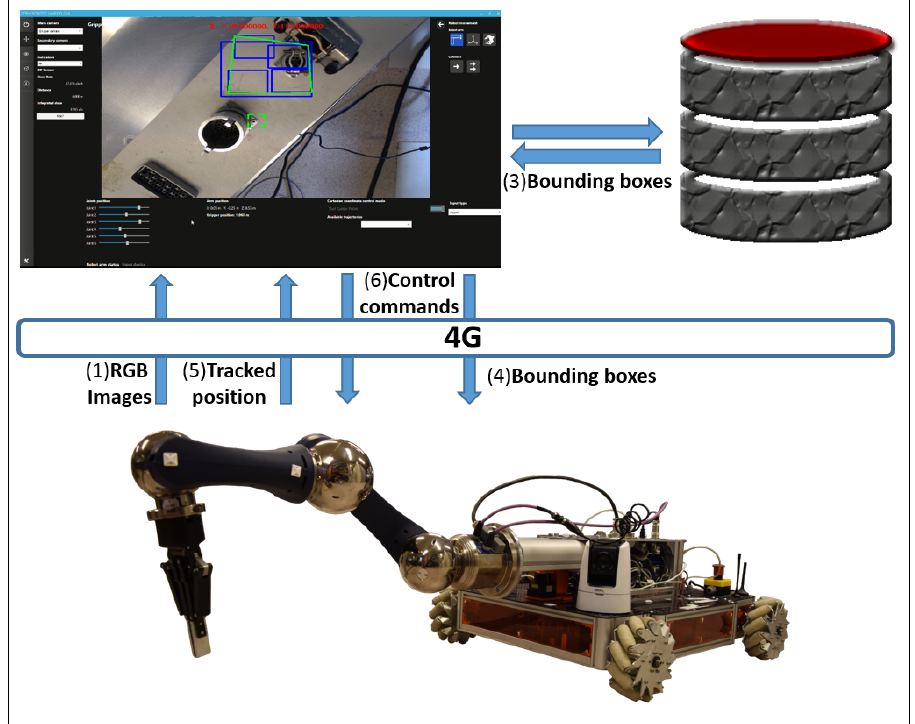
Figure 6. Deep Learning integration